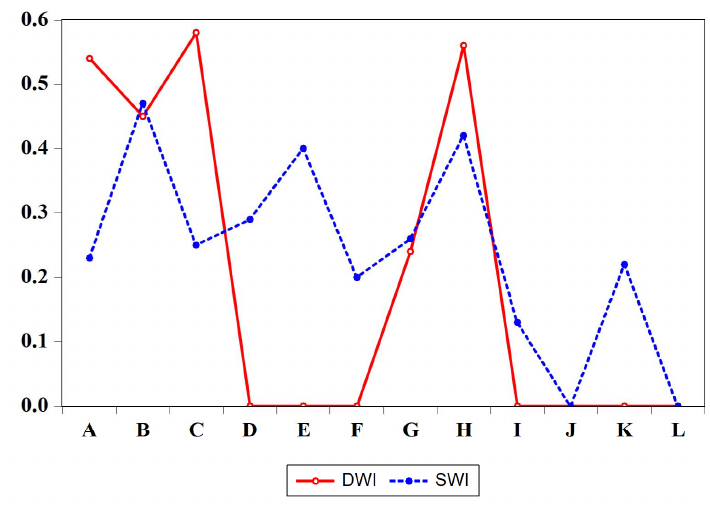
Figure 8. The shopping walking index (SWI) and dining walking index (DWI) values of each field site.